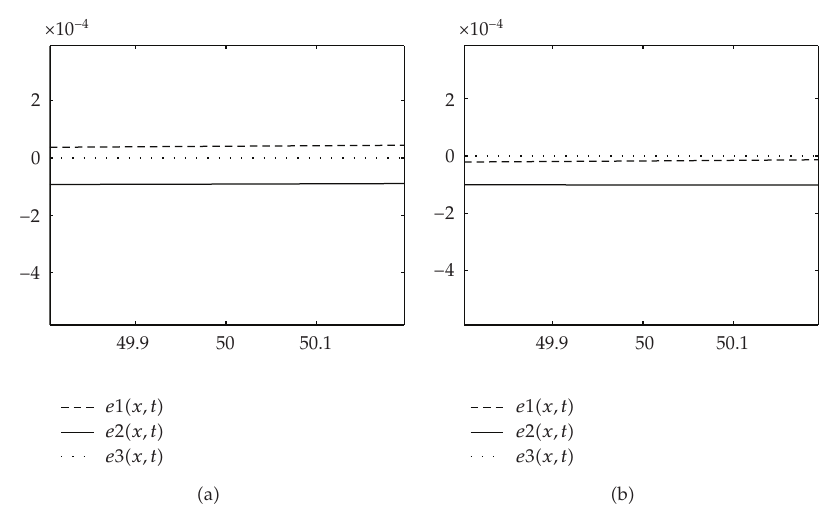
Figure 3: The error of u at (cid:3) a (cid:4) t (cid:7) 0 . 1 and (cid:3) b (cid:4) t (cid:7) 0 . 5 at space step 50; k (cid:7) 0 . 0001 ,h (cid:7) 1 / 5.